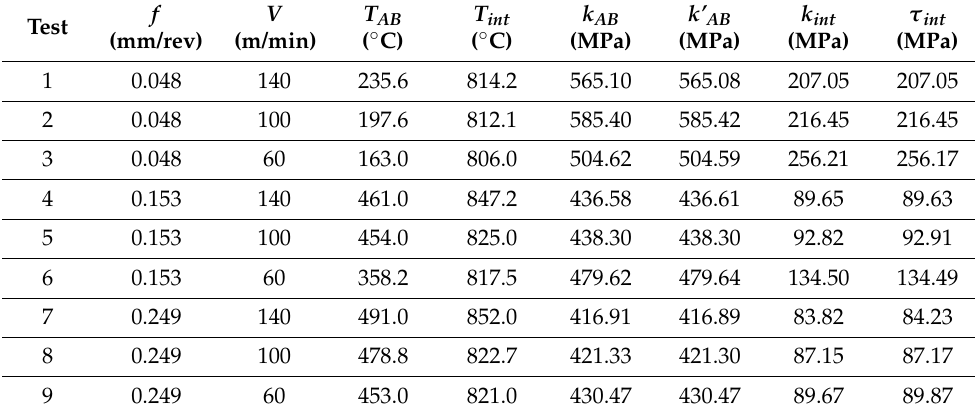
Table 11. The values determined for a p = 1.77 mm, α = 15 ◦ .